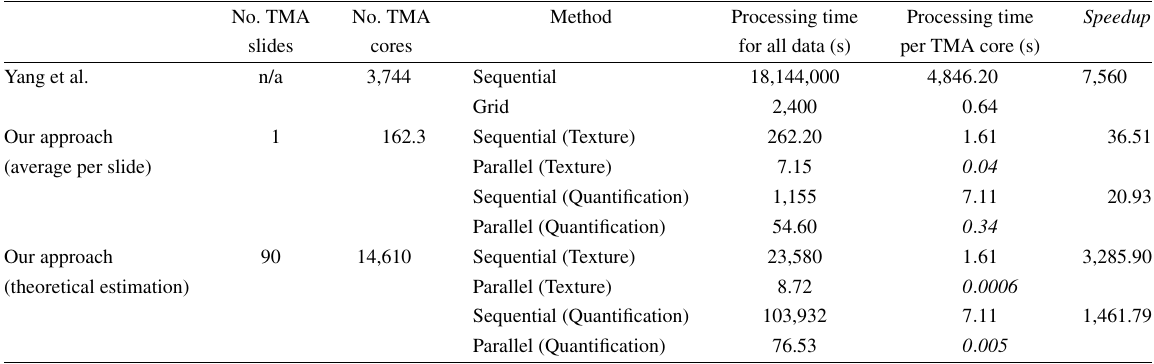
Computation performance comparison between the this study and Yang et